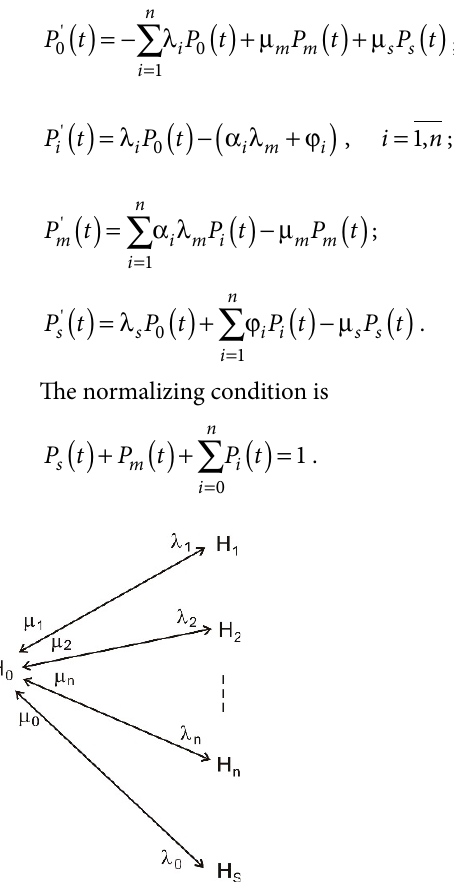
Fig. 13. Markov’s state transition diagram for a system without a condition-based monitoring